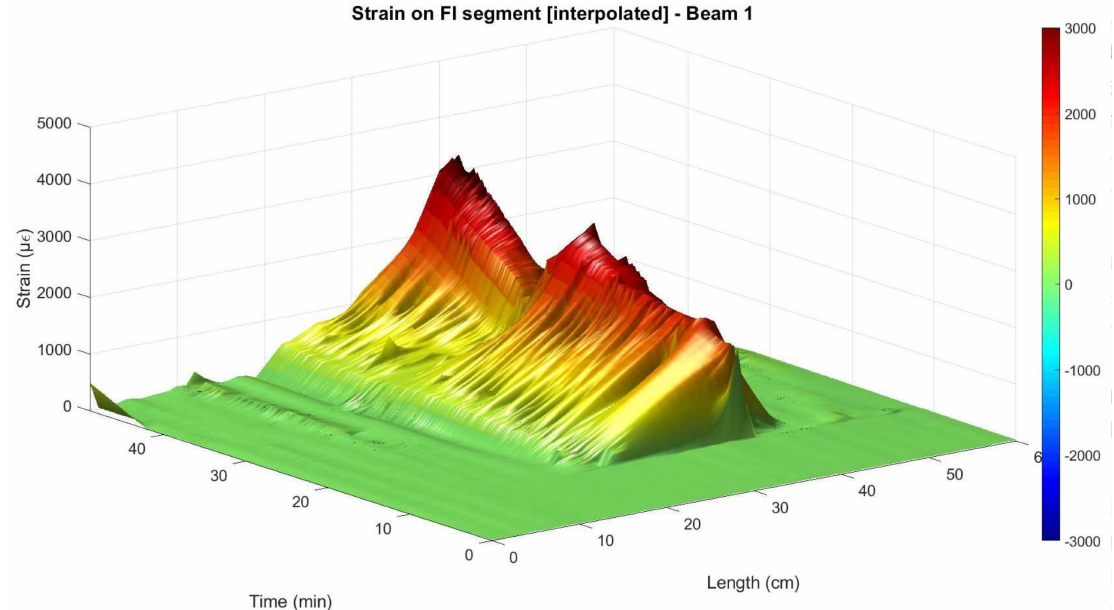
Figure 19. Interpolated measured strain at the embedded segment in Beam